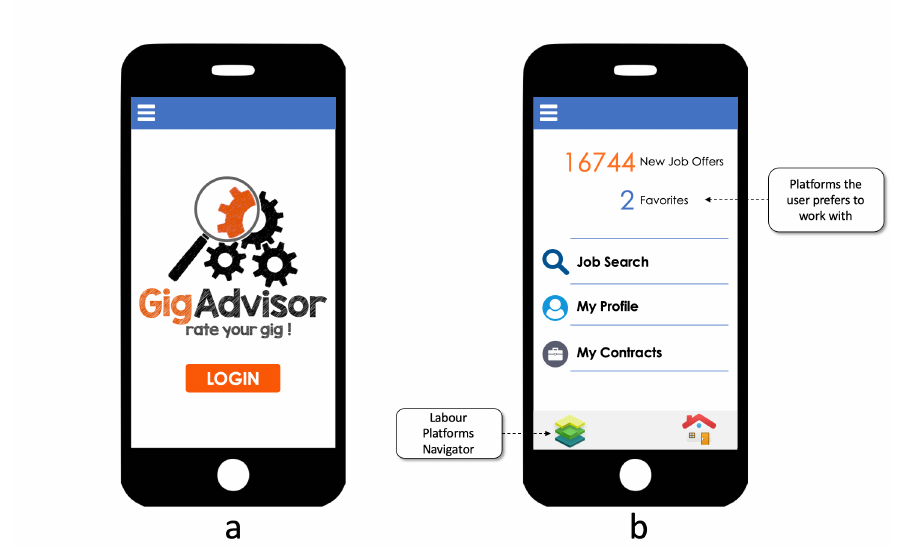
Figure 5. The GigAdvisor interface: ( a ) the home page, ( b ) the